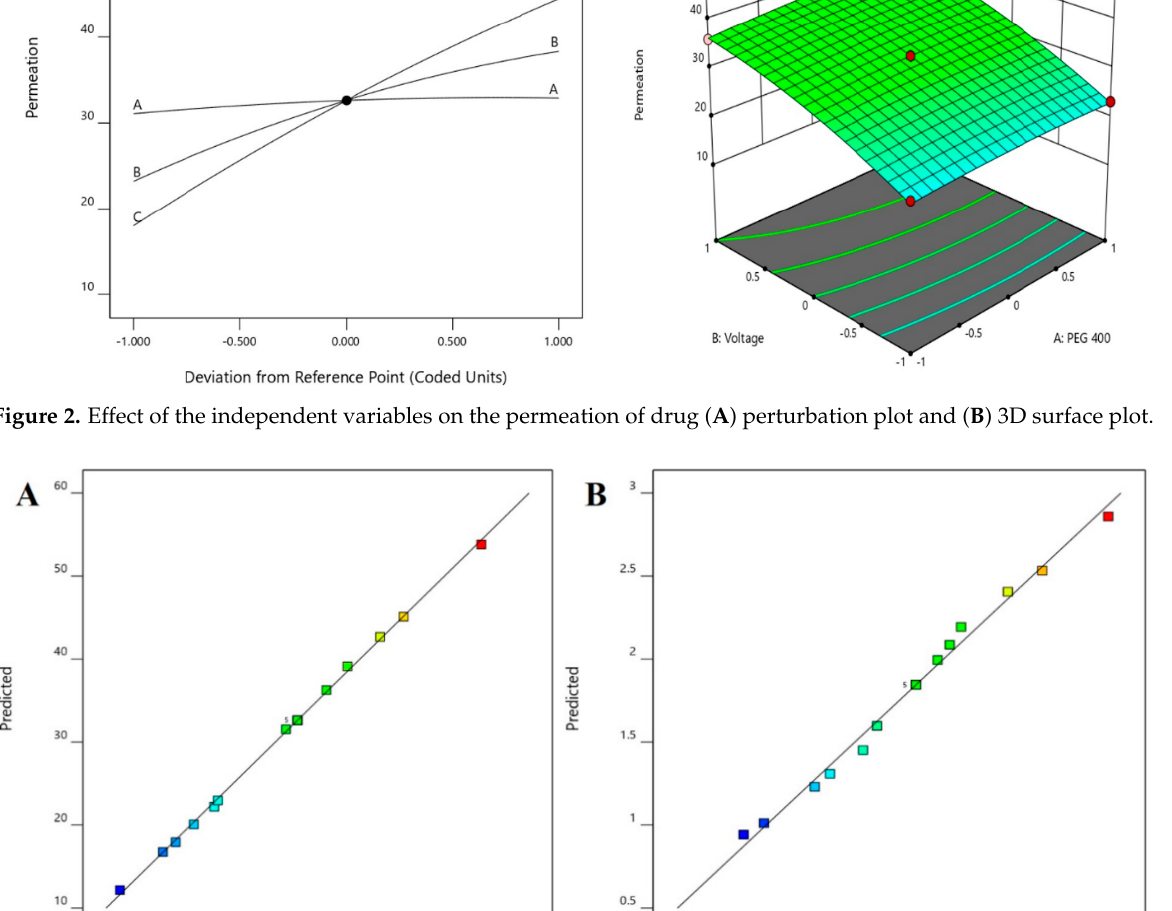
Figure 4. Contour plot response displaying the effect of independent variables on the permeation of drug ( A ) voltage versus PEG 400 and ( B ) application time versus voltage. 3.3.2. Effect of Independent Variables on Drug Accumulation on the Nails Similar to permeation, the drug accumulation into the nail tissue is another important parameter for transungual therapy with antifungal formulations, wherein the drug depot in nails will eventually release and exhibit antifungal therapeutic activity [53,54]. From the obtained report by the Box–Behnken statistical design, the model can be considered significant with the p- value of < 0.0001 ( p- value < 0.05), whereas the influence of all the independent variables (i.e., PEG 400 content, voltage, and application time) of the experi- mental design is found to have significant (Table 5) effect on the drug accumulation into the nail tissue.